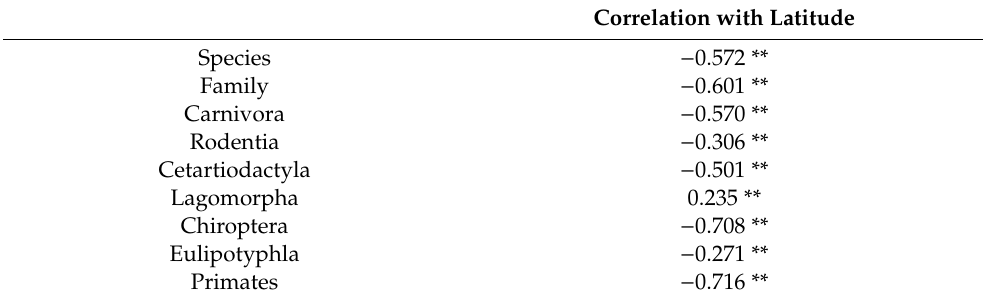
Table 3. Correlation coe ffi cients R for comparisons between mammalian richness and latitude.